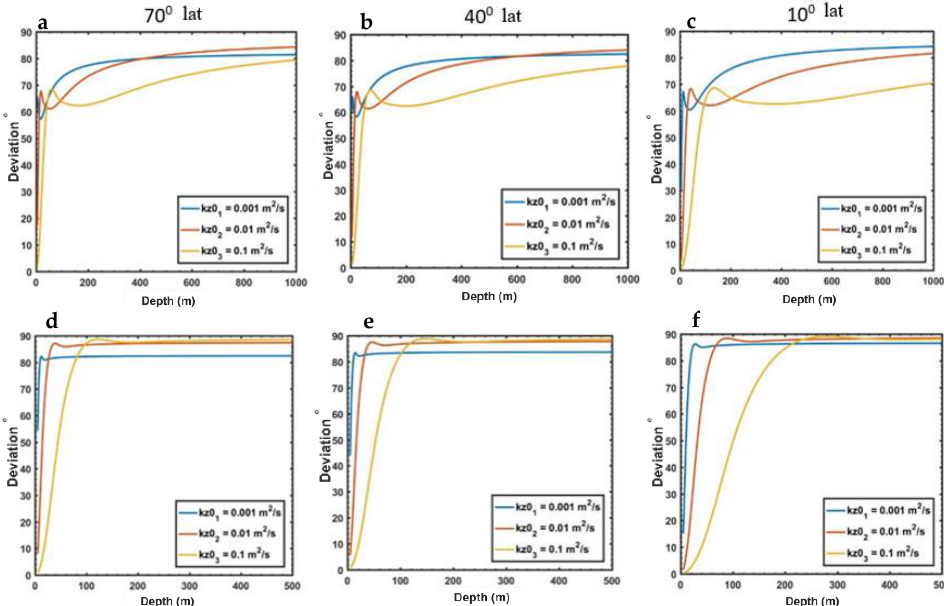
Figure 7. Ekman transport deviation — ( a – c ) correspond to a highly stratified profile. Graphs ( d – f ) belong to a slightly stratified profile.